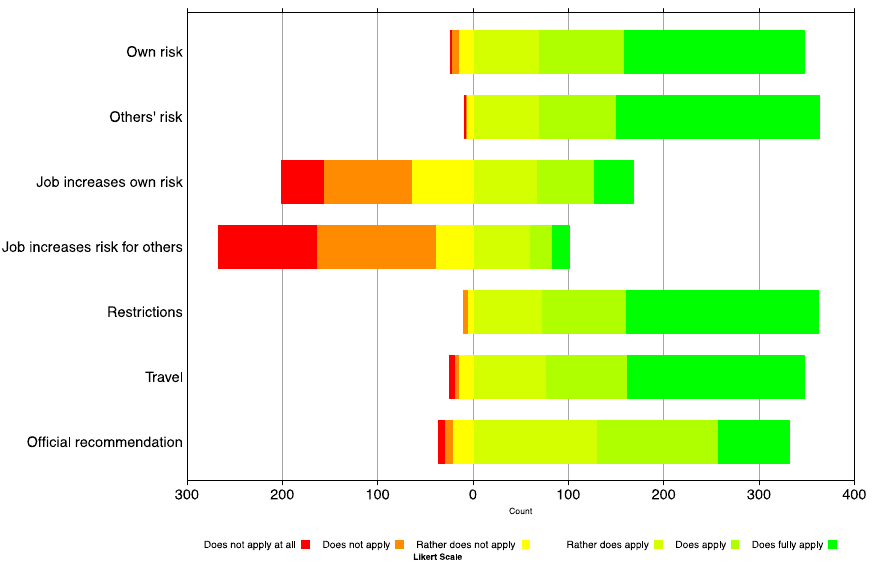
Figure 3. Frequency distribution of the answers on the motivation of getting vaccinated against COVID-19 in public pharmacies in the canton of Zurich (N = 372). A Likert scale of 6 + 1 was used, whereby “not answerable” was